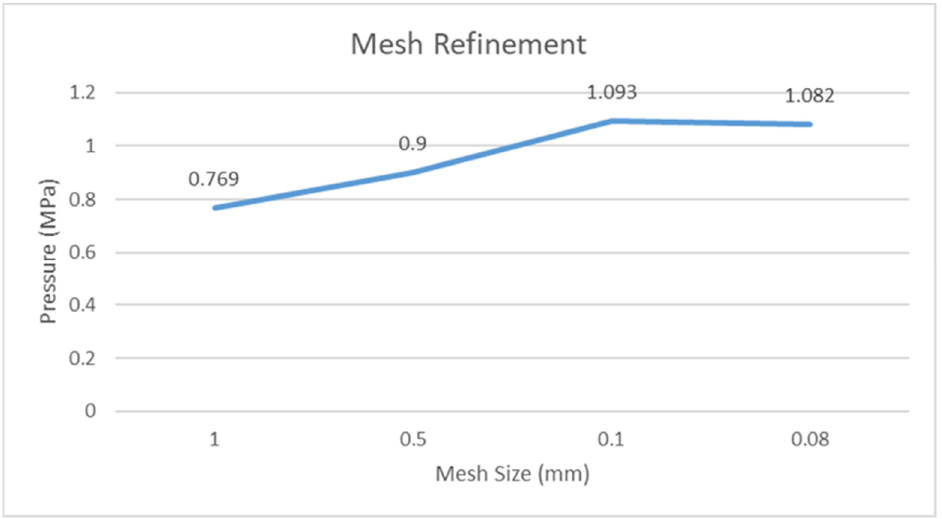
Figure 4. Effect of mesh size on the maximum hydrodynamic pressure (ANSYS Fluent).